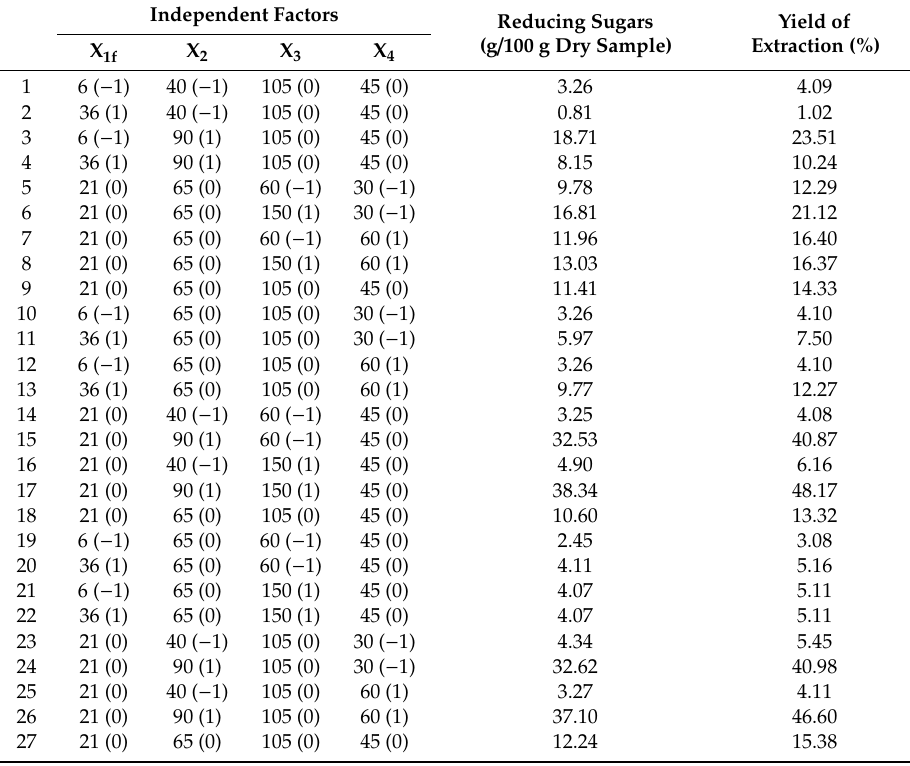
Table 3. Box–Behnken design with natural and coded values for chemical hydrolysis conditions with H 3 PO4 and experimental values of reducing sugars quantified by Schoorl